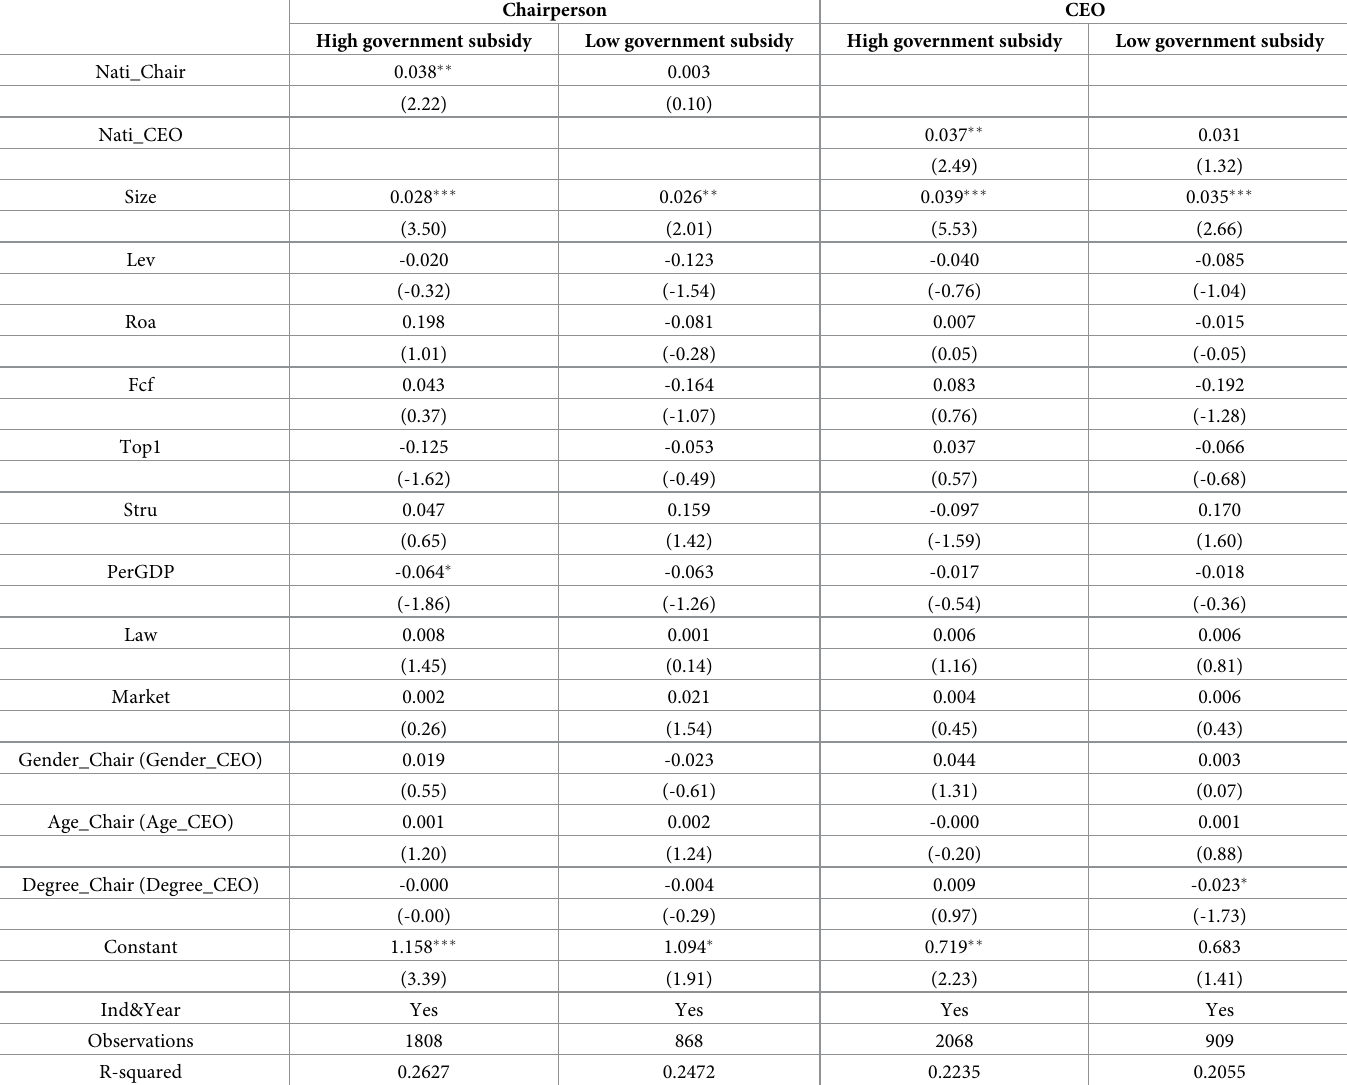
Table 12. Government subsidies, senior executive home bias and employee social